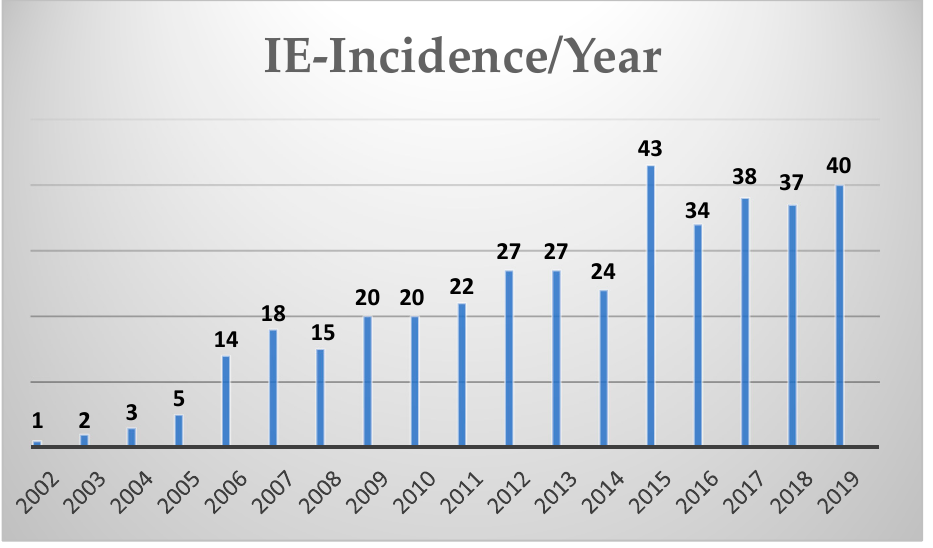
Figure 1. Showing the yearly incidence of infective endocarditis treated surgically over the last 18